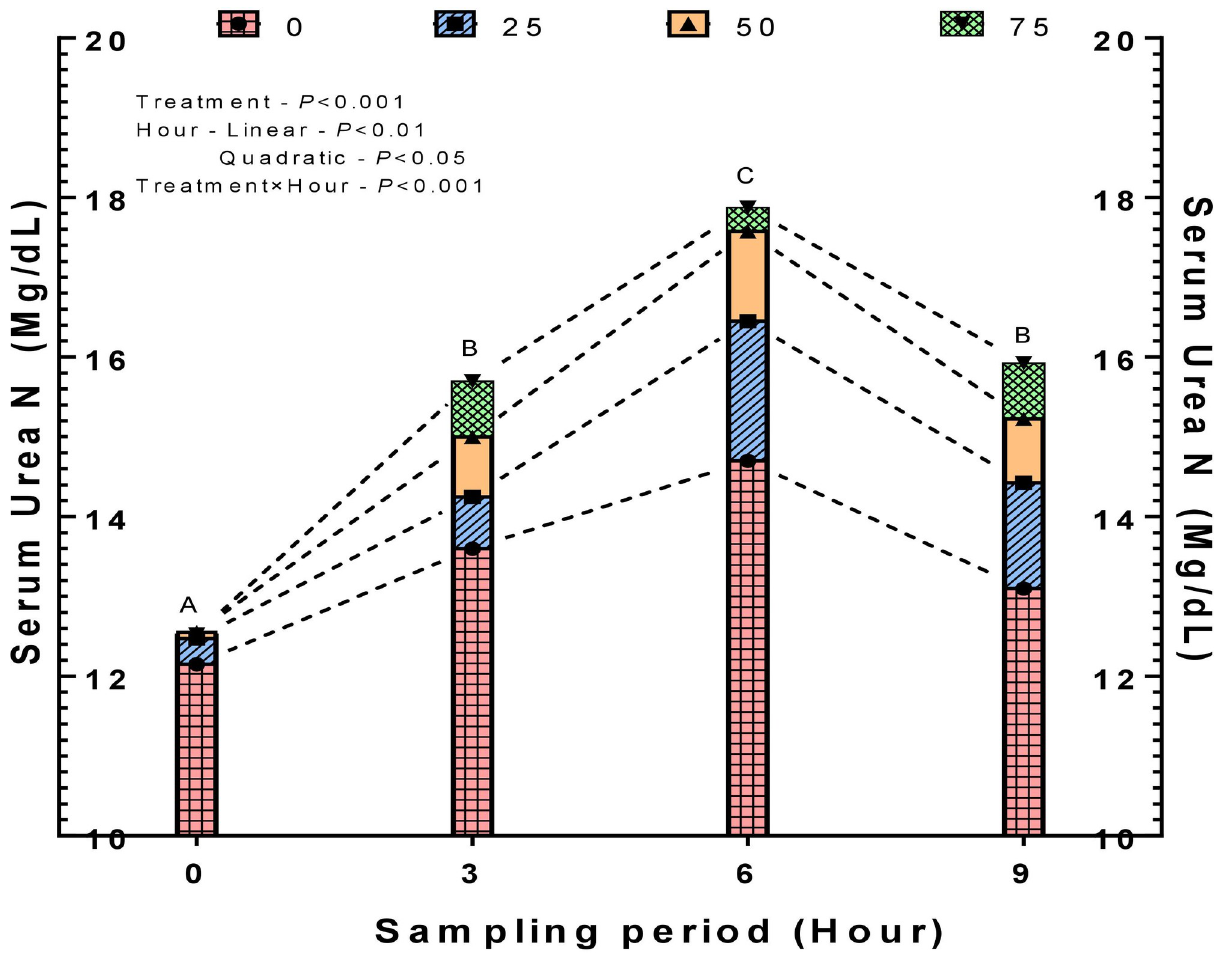
Fig 3. Mean serum urea nitrogen as a function of time and replacements of soybean meal (R 2 = 0.838; SUN = 10.276+1.282 × SRU+0.529 × SRU × TIME+0.801 × TIME–0.100 × TIME 2 ).